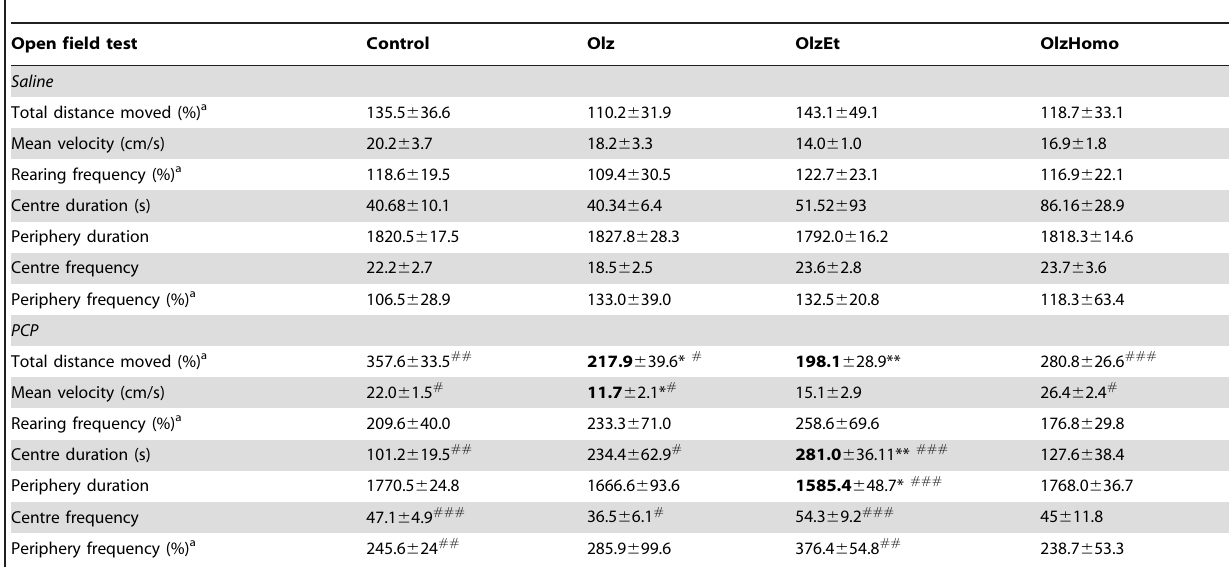
Table 3. Open field test in male rats treated with Olz and Olz